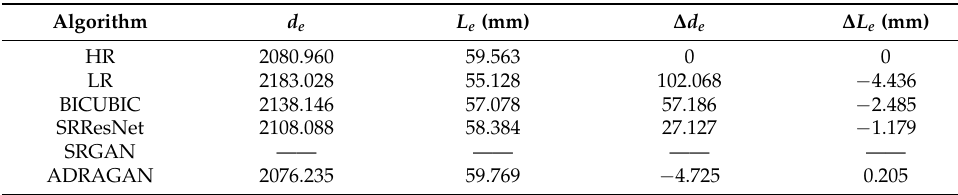
Table 6. Comparison results for the various